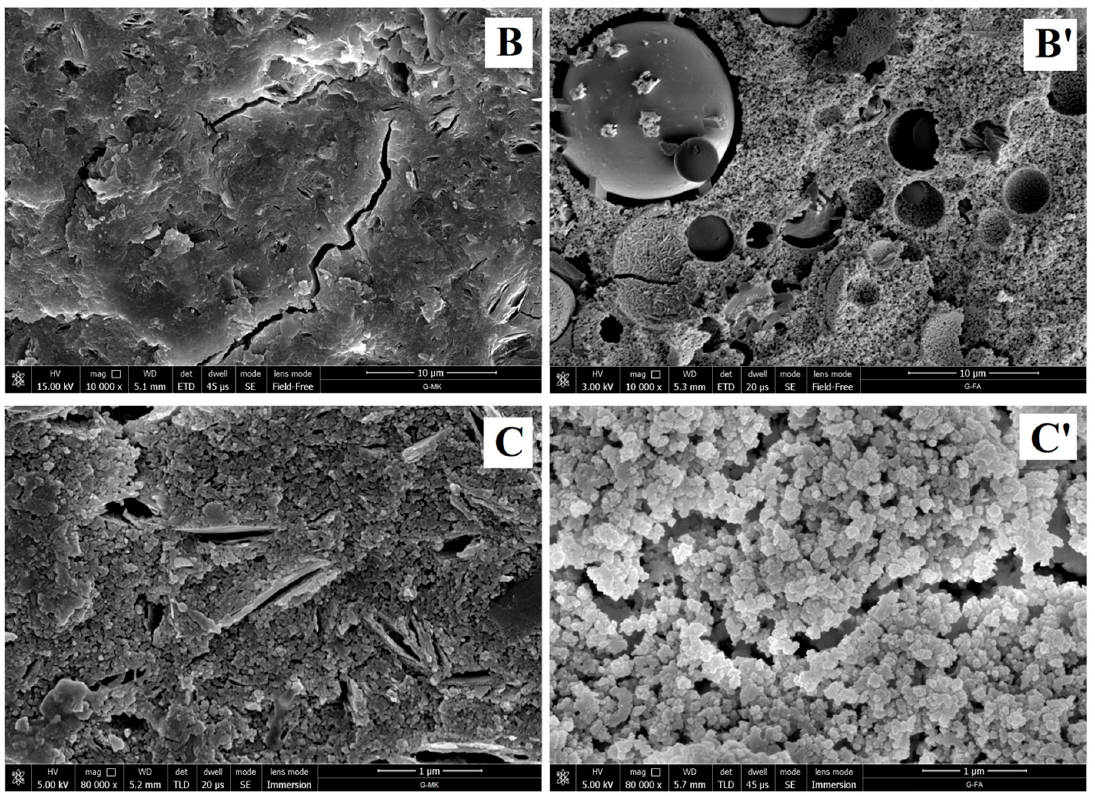
Figure 6. Scanning electron microscope (SEM) micrographs of MK-based geopolymer ( A – C ) and FA-based geopolymer ( A’ – C’ ).